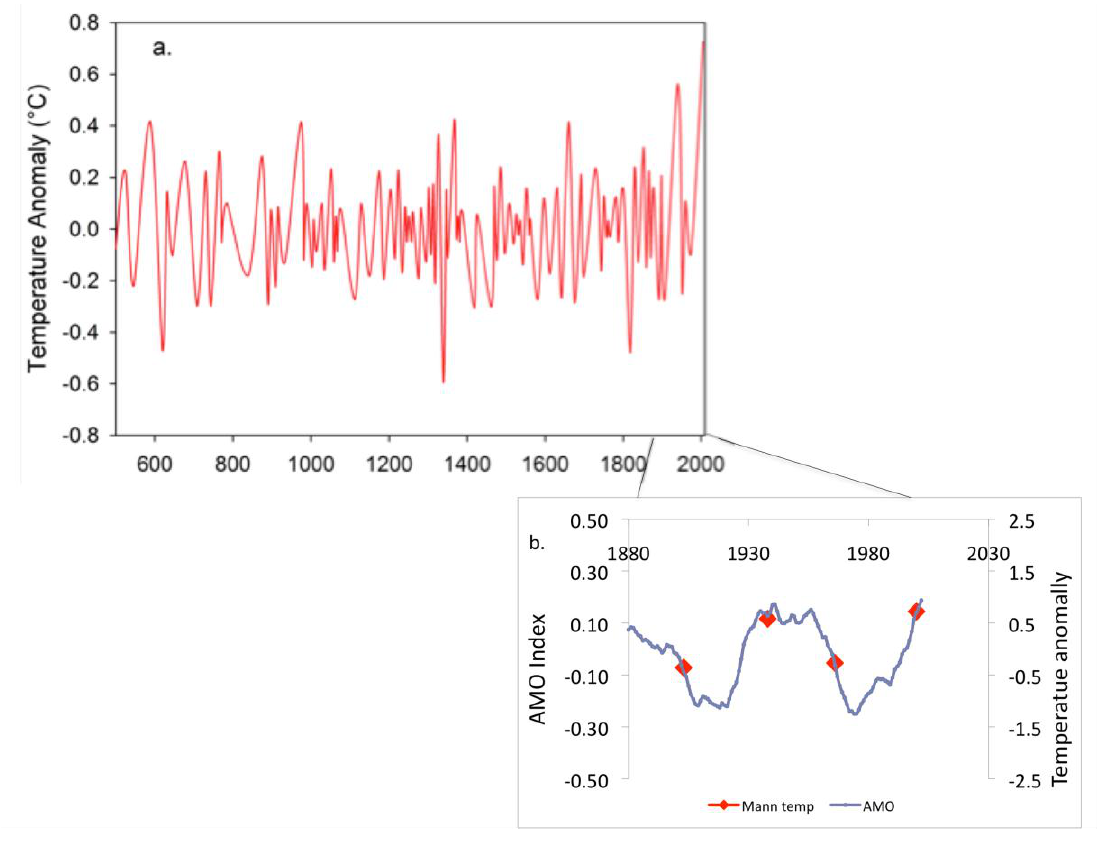
Figure 2. ( a ) Mann Temperature anomalies (where the mean temperature is set to zero and differences from the mean are plotted) from all-proxy record for the Northern Hemisphere from 500 to 2006 indicate an increase in temperature from the 1800s on, adapted from the Mann et al. [8]. Trends in the record like the Little Ice Age and Global Warming have been removed by providing only the differences in adjacent maximum and minimum ranges (peaks and valleys) of temperatures and not the actual temperature. The difference between successive maximum and minimum were plotted from the zero line. The average cycle peak to peak from 500–2006 is 75 years. ( b ) The Mann temperature anomalies (red) and the Atlantic Multidecadal Oscillation from ship and satellite measurements: AMO smoothed from Kaplan Sea Surface Temperature version 2 calculated at NOAA/ESRL/PSD1 accessed July 2014